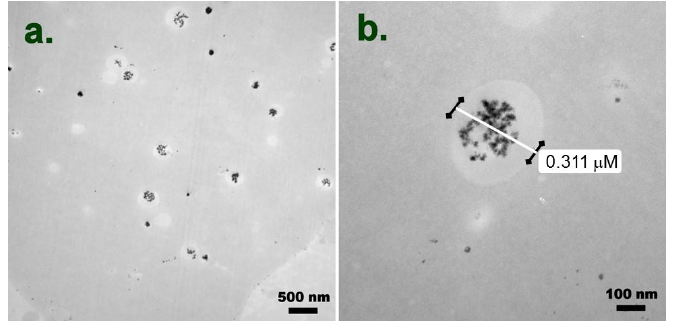
Figure 2. TEM images of iron oxide-modified NE in histo-gel at ( a ) 19,000×; and ( b ) 130,000×.